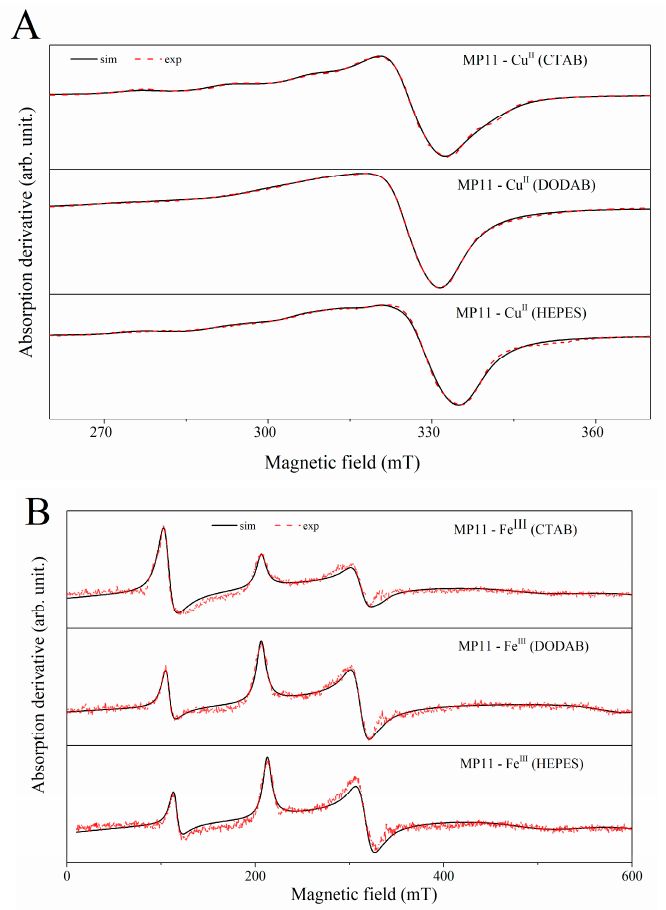
Figure 5. Experimental and simulated EPR spectra of MP-11 with Fe(III) ( A ) and Cu(II) ( B ) as the central metals in HEPES, CTAB, and DODAB, as indicated and obtained with frozen solutions of same concentrations. The EPR parameters used are shown in Table 2.